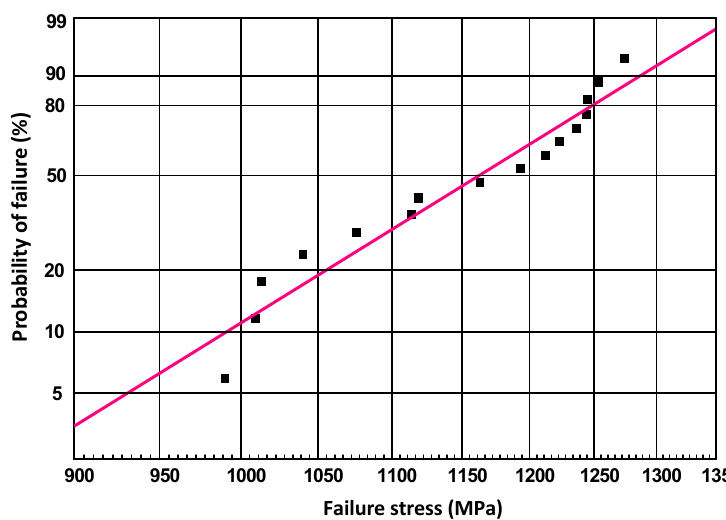
Figure 7. Industrial computed tomography (CT) images of a Si 3 N 4 floatation sphere. ( a , b ) CT scanning. ( c ) Slight misalignment at the joint.